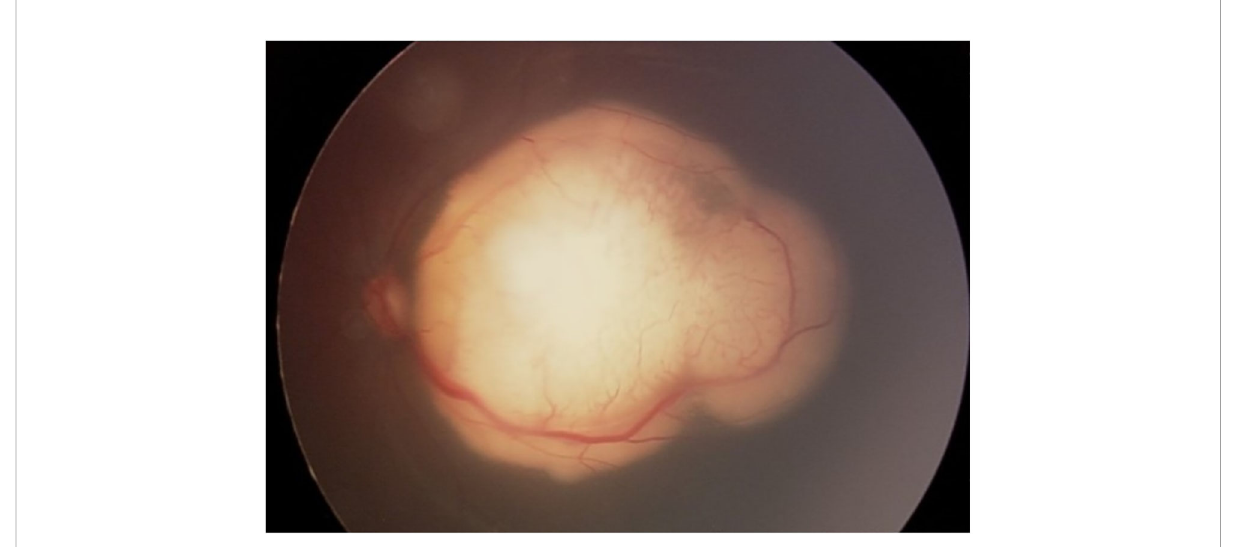
FIGURE 1 Retinoblastoma in the posterior